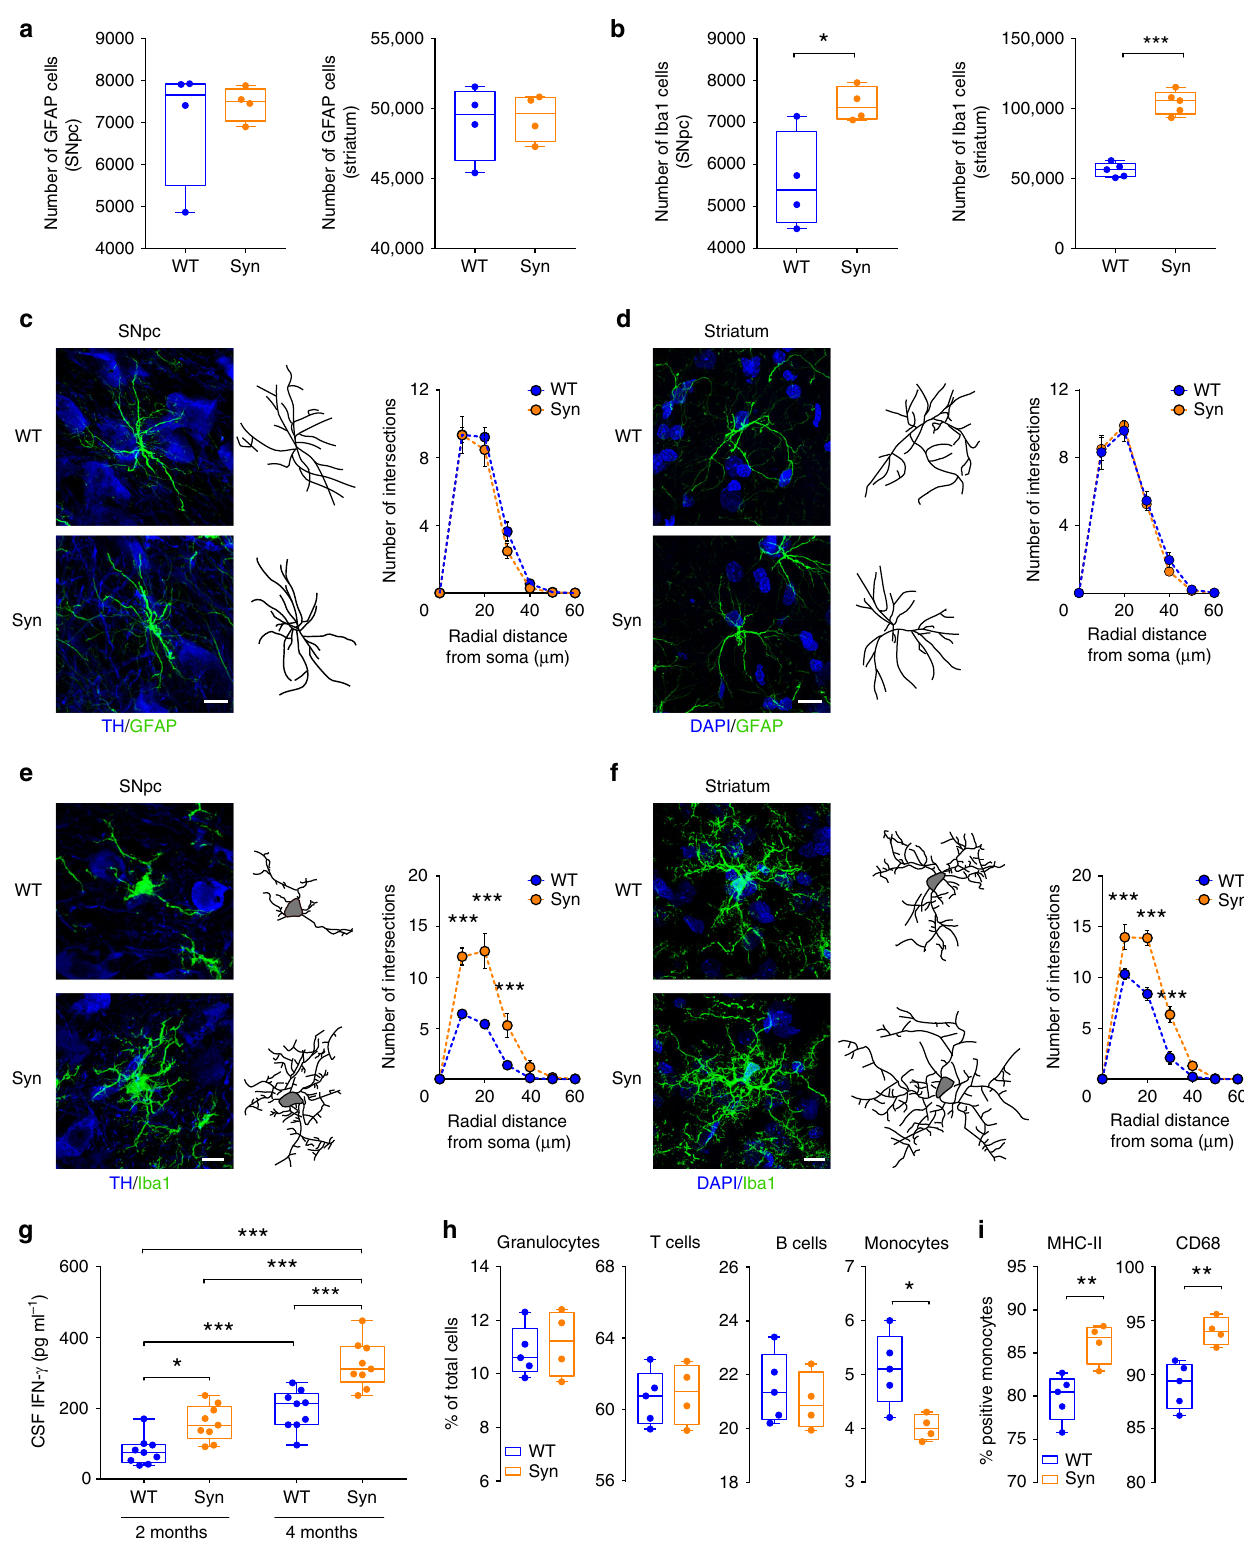
sought to analyse whether the region-speci fi c in fl ammation in Syn rats (microglia changes in the SNpc, striatum and hippo- campus, but not in the pontine nuclei) could be correlated with selective local aggregation of α -syn species. We used an antibody against conformation-speci fi c α -syn aggregates and fi brils (MJFR- 14-6-4-2) to estimate the amount of pathological α -syn in